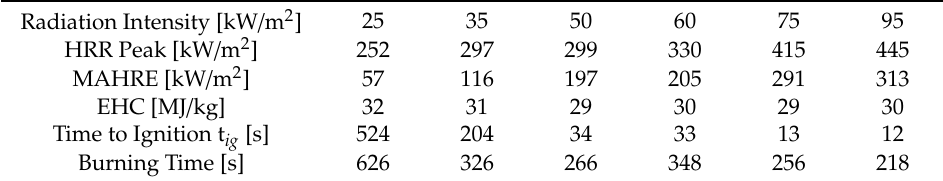
Table 4. Combustion parameter of PA 6 yield with different radiation intensity .